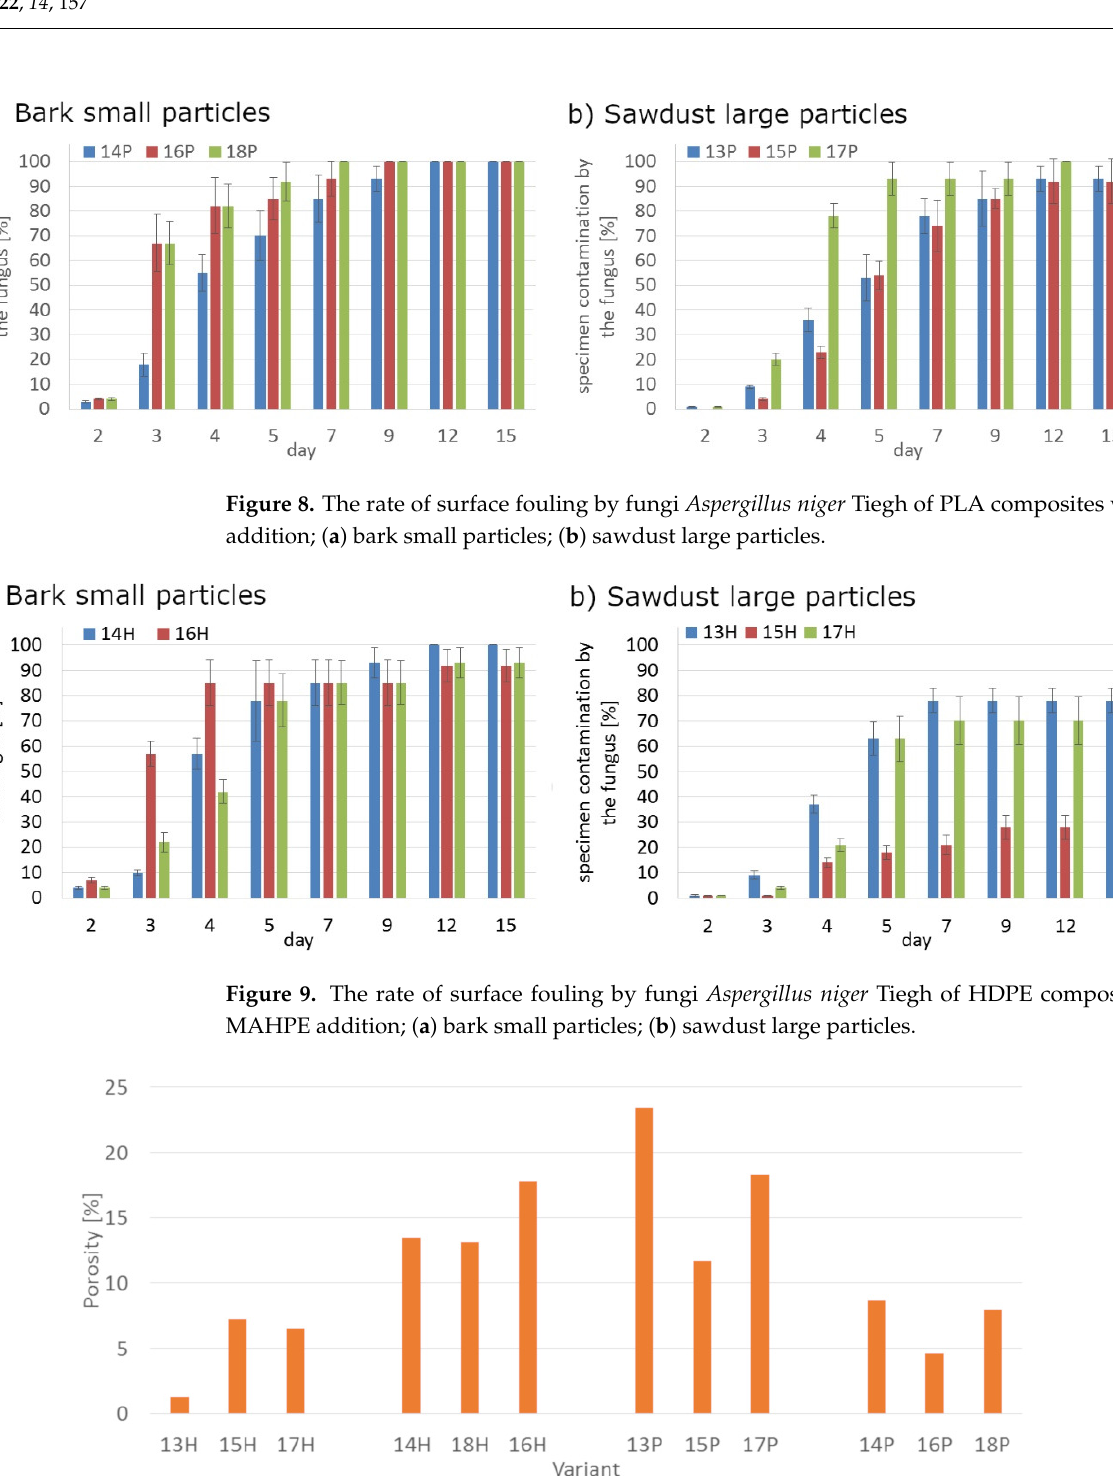
9 of 13 Figure 6. Example of mold growth ( Aspergillus niger Tiegh) after 7 days of exposure of composite samples with small particle sawdust filler of 60%, based on a matrix: ( a ) HDPE; ( b ) PLA.